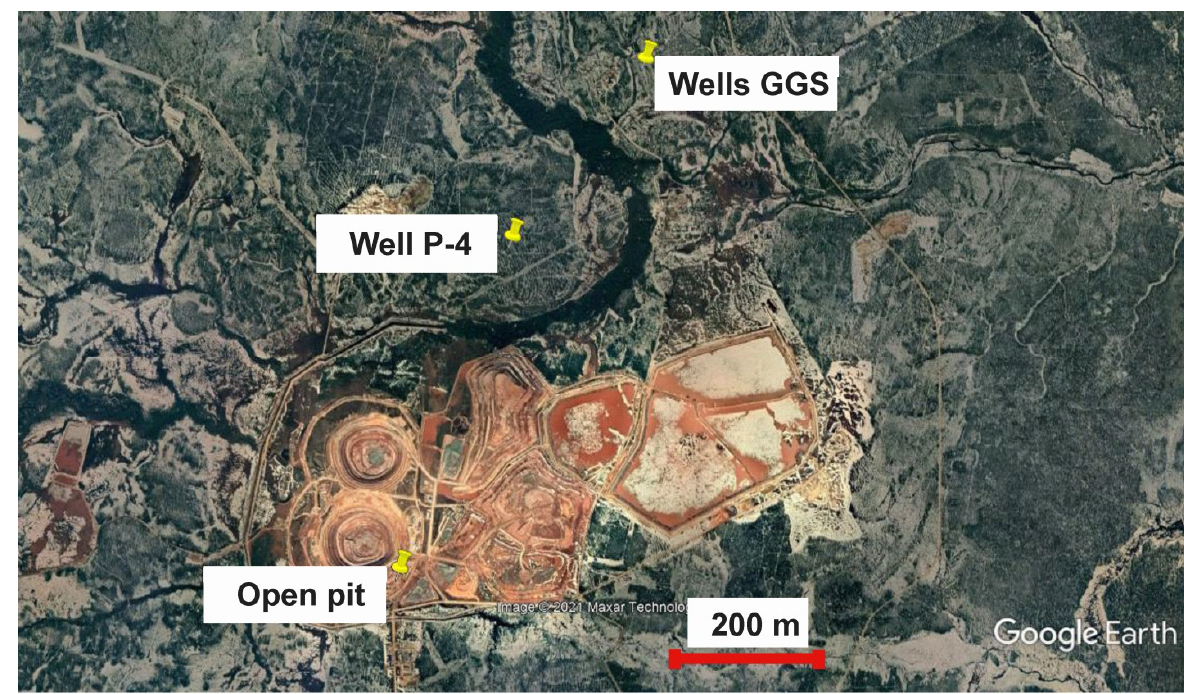
Figure 1. Core sampling locations. “Wells GGS” are the GGS2-10 and GGS2-11 boreholes with a depth of 102 and 101.2 m. “Well P-4” is a hydrogeological borehole with a depth of 214 m. “Open pit” is Quarry on the Arkhangelskaya kimberlite pipe of the Lomonosov diamond deposit with a depth of 210 m.